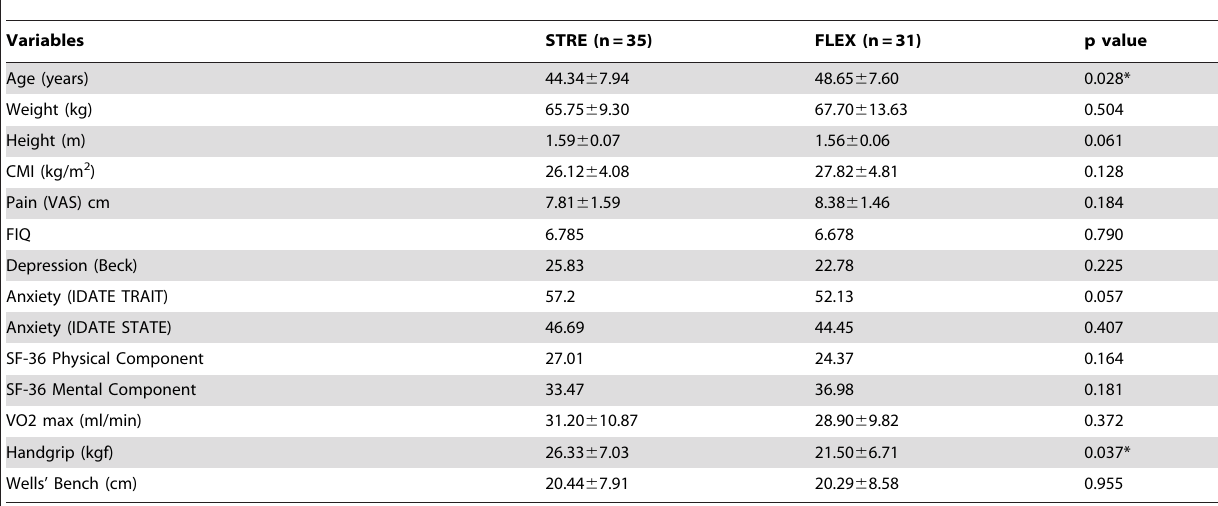
The values are presented as the means 6 SD. STRE: strengthening exercise, FLEX: Flexibility exercise. FIQ: Fibromyalgia Impact Questionnaire. SF-36: Short-Form healthy Survey. VO2 max: maximal oxygen uptake. Wilcoxon Test: intra-group comparison. ANOVA: inter-group comparison, analysis of variance for repeated measures, p